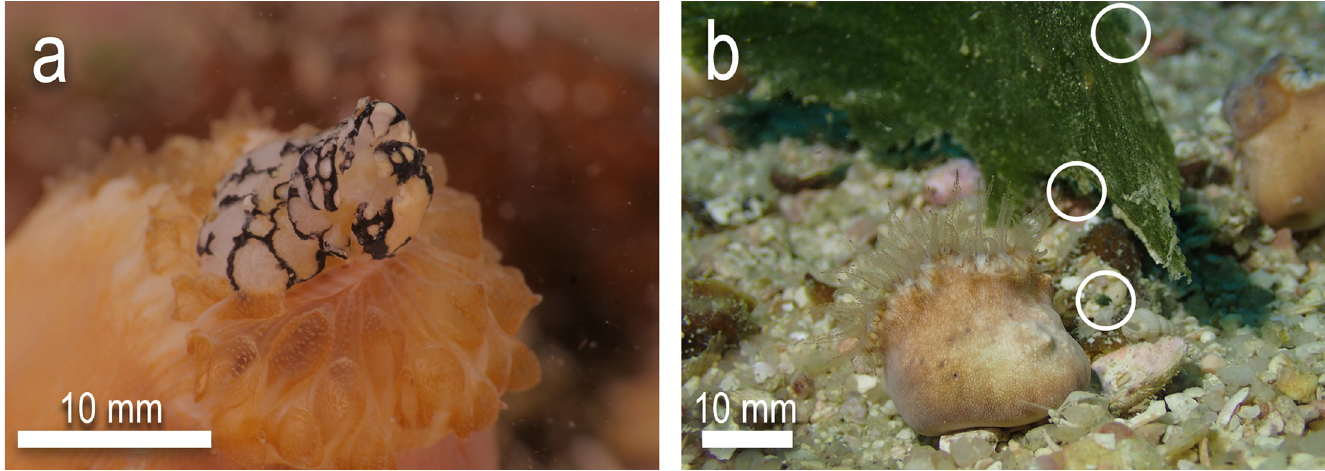
Fig 7. In-situ observations of natural predation of sea slugs by Heteropsammia cochlea . a) Partial ingestion of Tubulophilinopsis pilsbryi by H . cochlea b) Heteropsammia cochlea in close proximity to Avrainvillea erecta , hosting multiple Costasiella individuals (circled, partially visible).